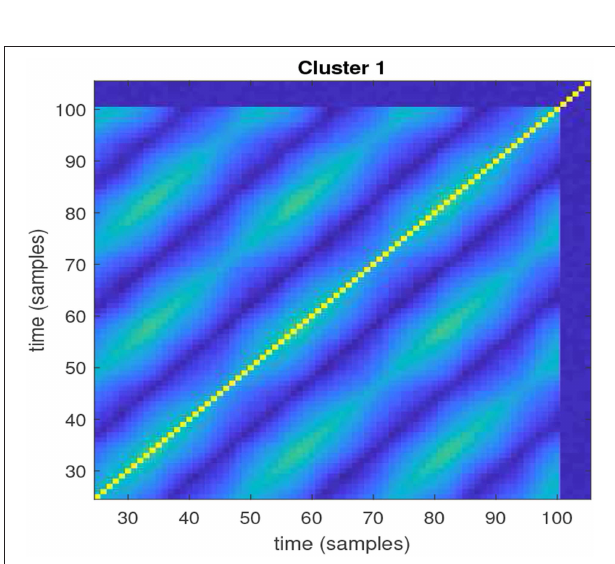
0 and c 1.2. The simulation shows two periods of the spiraling wave. = =